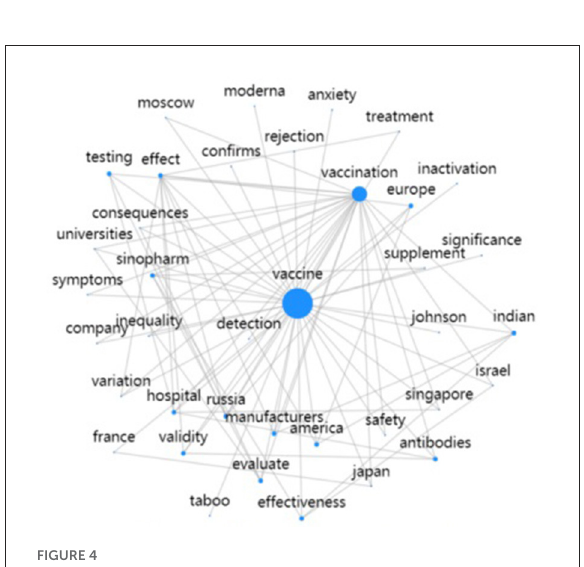
FIGURE4 Keyword co-word